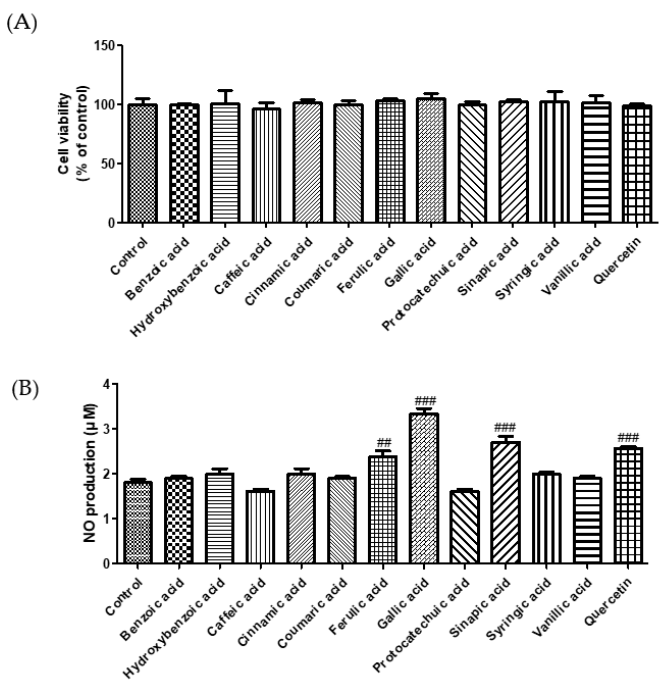
Figure 2. Effect of selected phenolic acids (50 µ M) on cell cytotoxicity ( A ) and NO production ( B ) in EA.hy 926 cells. Quercetin (25 μ M) was used as positive control. Each value was expressed as the mean ± standard error ( n = 3). Statistical significance was analyzed using the Tukey test. ## p < 0.01 and ### p < 0.001 versus nontreated cells.